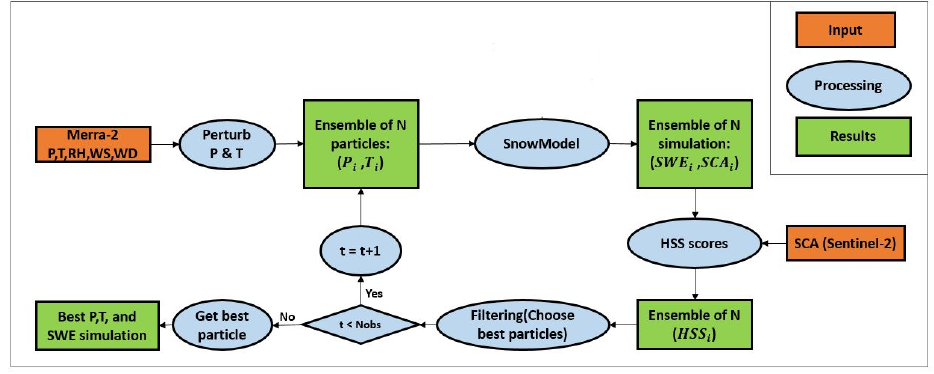
Figure 6. Description of the data assimilation scheme used in this